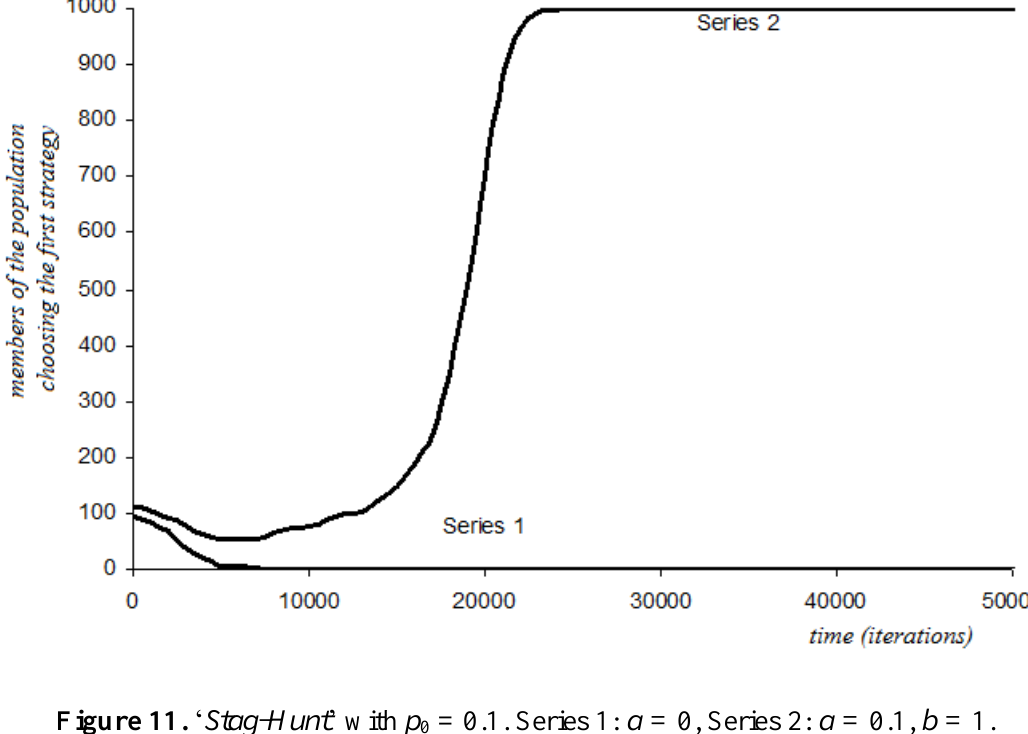
Figure 11. ‘ Stag-Hunt ’ with p